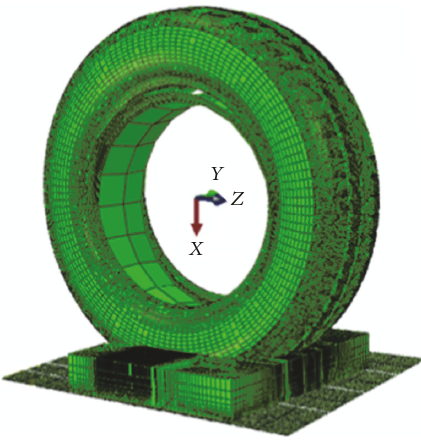
Figure 9: Tire hydroplaning FE model.